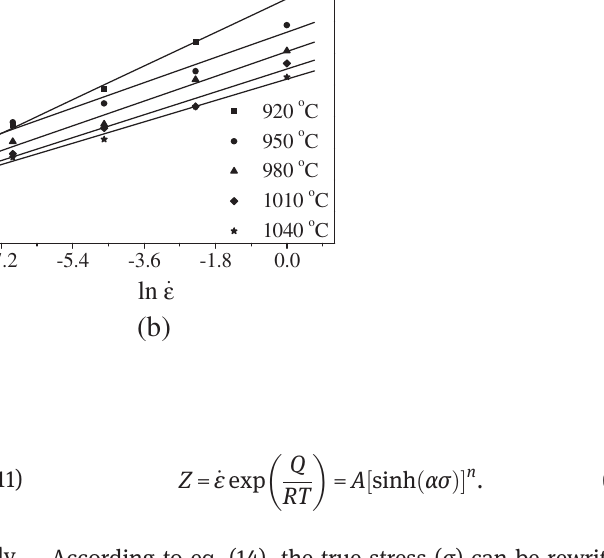
Figure 3a illustrates ln sinh ασ ð Þ½ (cid:2) and ln _ ε plot. Visibly,